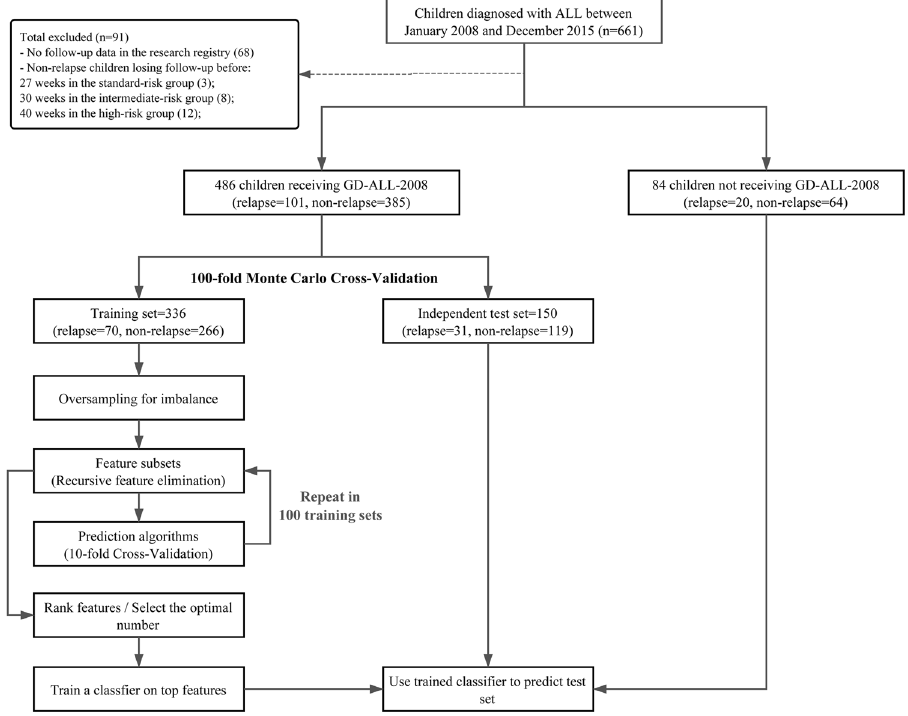
Figure 3. Flow chart of data collection, data preprocessing, feature selection and model development. The overall data set was made up of 570 patients and 121 out of them were